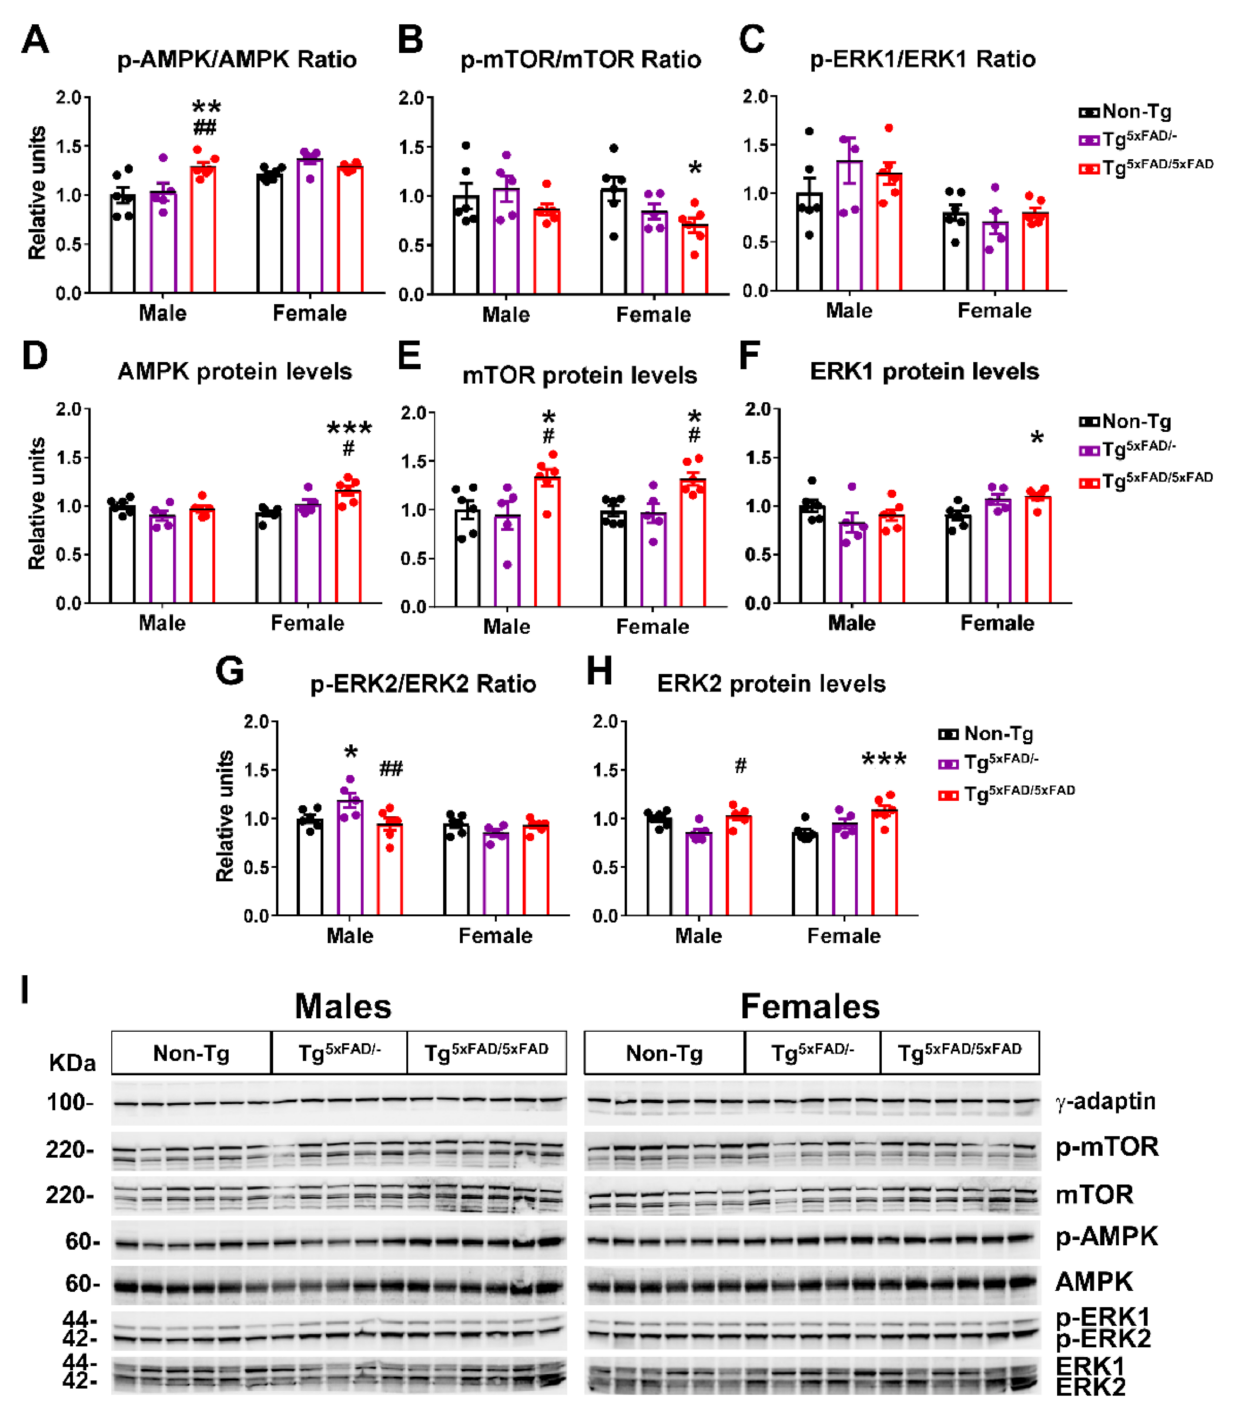
Figure 7. Metabolic sensors AMPK, mTOR, and ERK were altered as a consequence of impaired insulin signaling in the hypothalamus of 5xFAD mice at 6 months of age. ( A – H ) Representation of Western blot membranes and ( I ) densitometric evaluation of AMP kinase (AMPK) activation (p-AMPK/AMPK), AMPK protein levels, mammalian target of rapamycin (mTOR) activation (p-mTOR/mTOR), extracellular-regulated kinase 1 (ERK1) activation (p-ERK1/ERK1), ERK1 protein levels, ERK2 activation (p-ERK2/ERK2), and ERK2 protein levels ( n = 5–6 per group). Protein levels were normalized with γ -adaptin. Associated phosphorylations were normalized with respective total protein levels. Non-Tg males were set as 1 for protein relative units. Two-way ANOVA analysis with Tukey’s post hoc test: * = p < 0.05, ** = p < 0.01, *** = p < 0.001 versus same-sex non-Tg group; # = p < 0.05, ## = p < 0.01 versus same-sex Tg 5xFAD/-